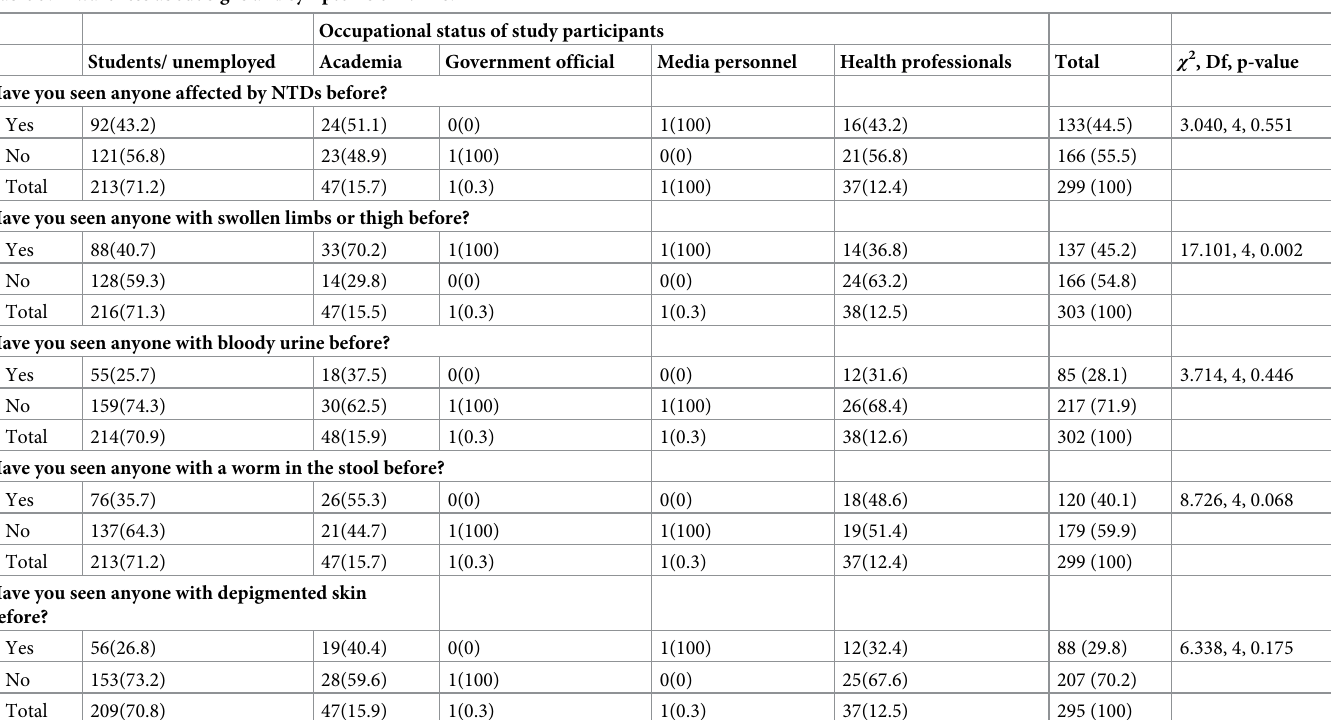
Table 3. Awareness about signs and symptoms of